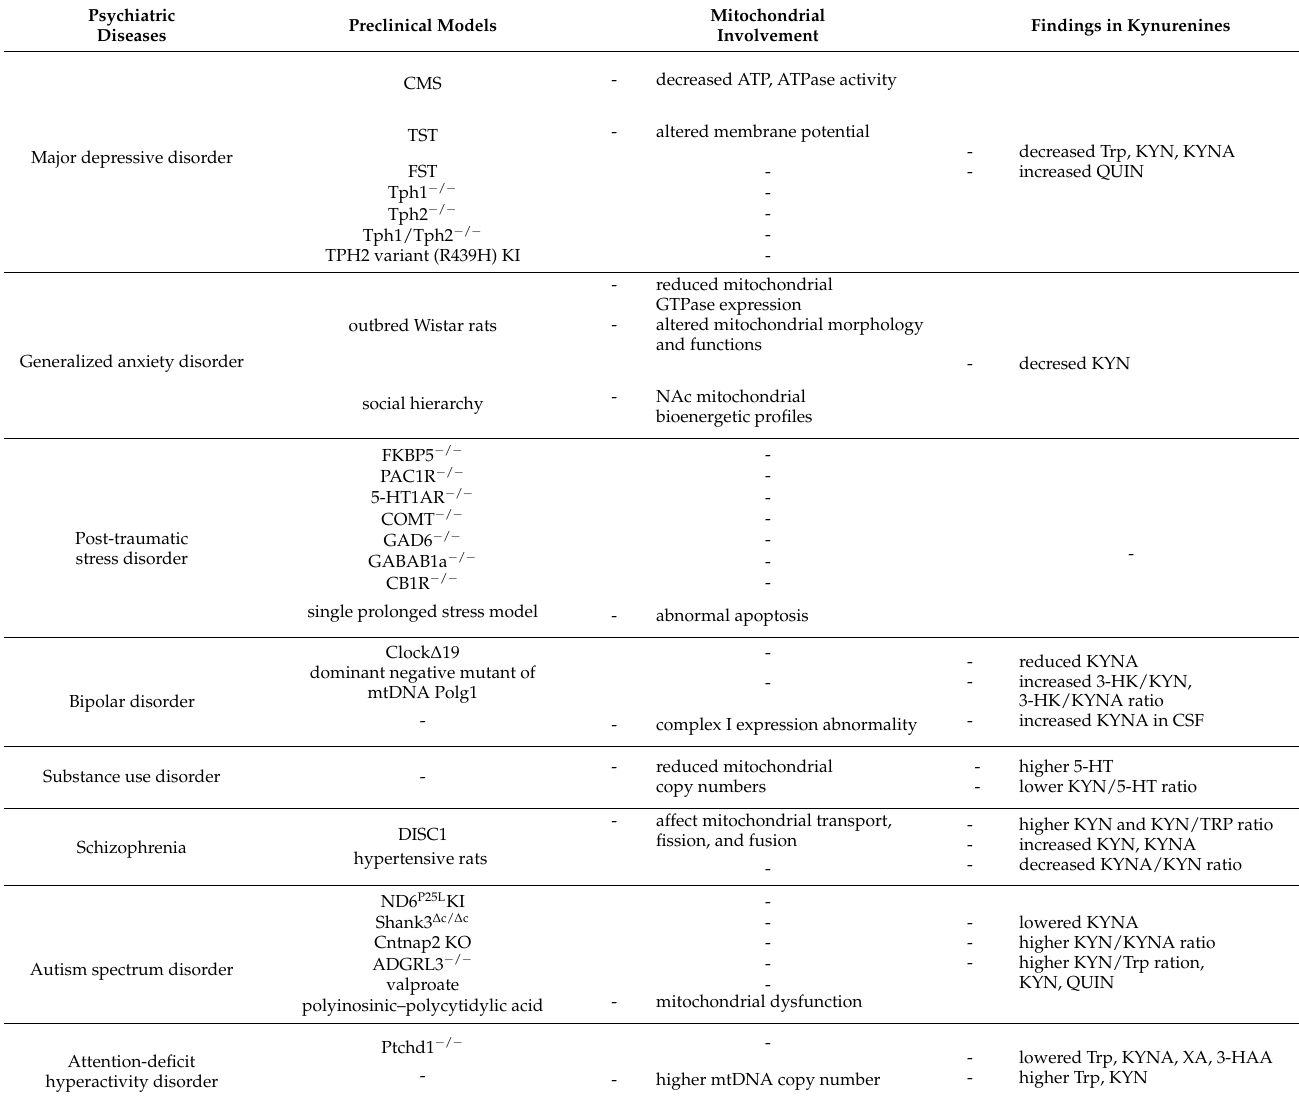
Table 3. The preclinical models, mitochondrial involvement, and findings in kynurenines in main psychiatric